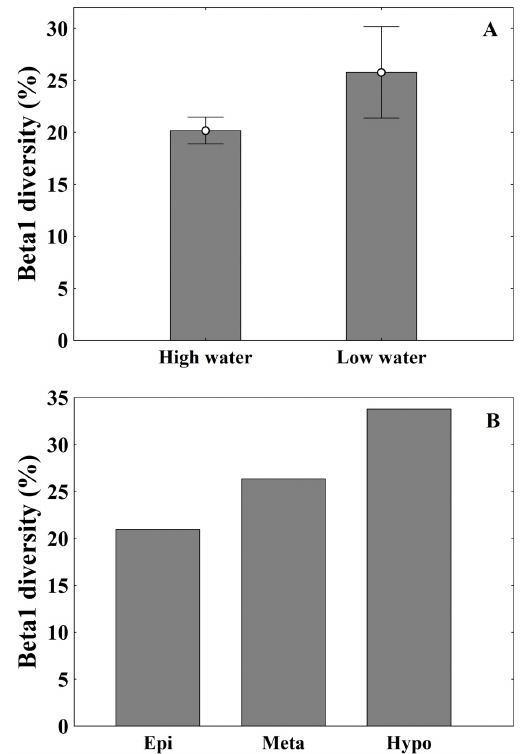
Figure 8. Beta1 diversity index showing species turnover (%) among strata during two hydrological periods (A) and between hydrological periods in the distinct strata (B). Epi=Epilimnion, Meta=Metalimnion, Hypo=Hypolimnion.